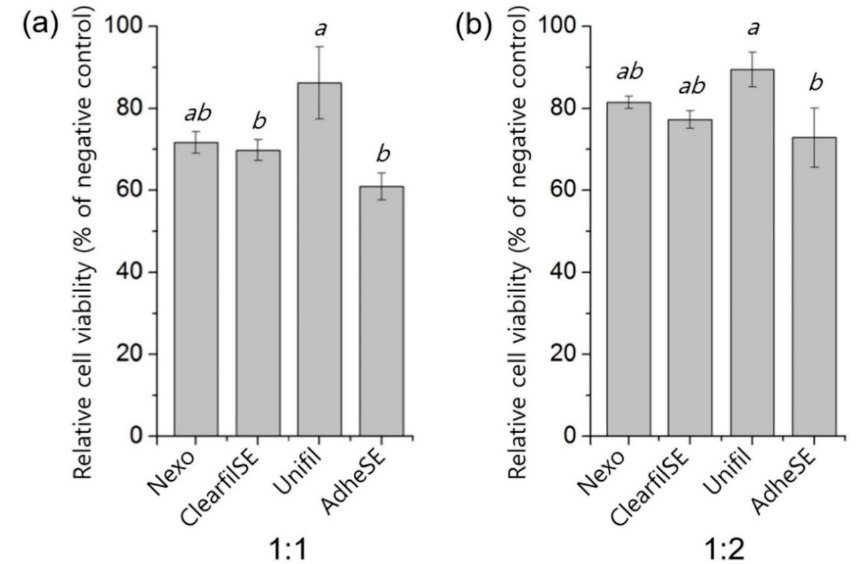
Figure 5. MTT assay (% of negative control). The ratio ( a ) 1:1 means 100% of extraction and ( b ) 1:2 means extraction and non-serum media ratio. The same letters mean no significant differences. Raw data are presented in Tables S6 and